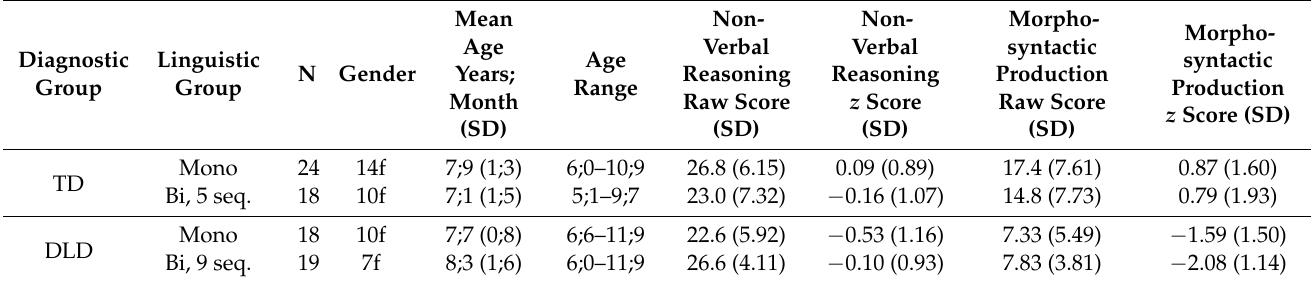
Table 1. Descriptive data on